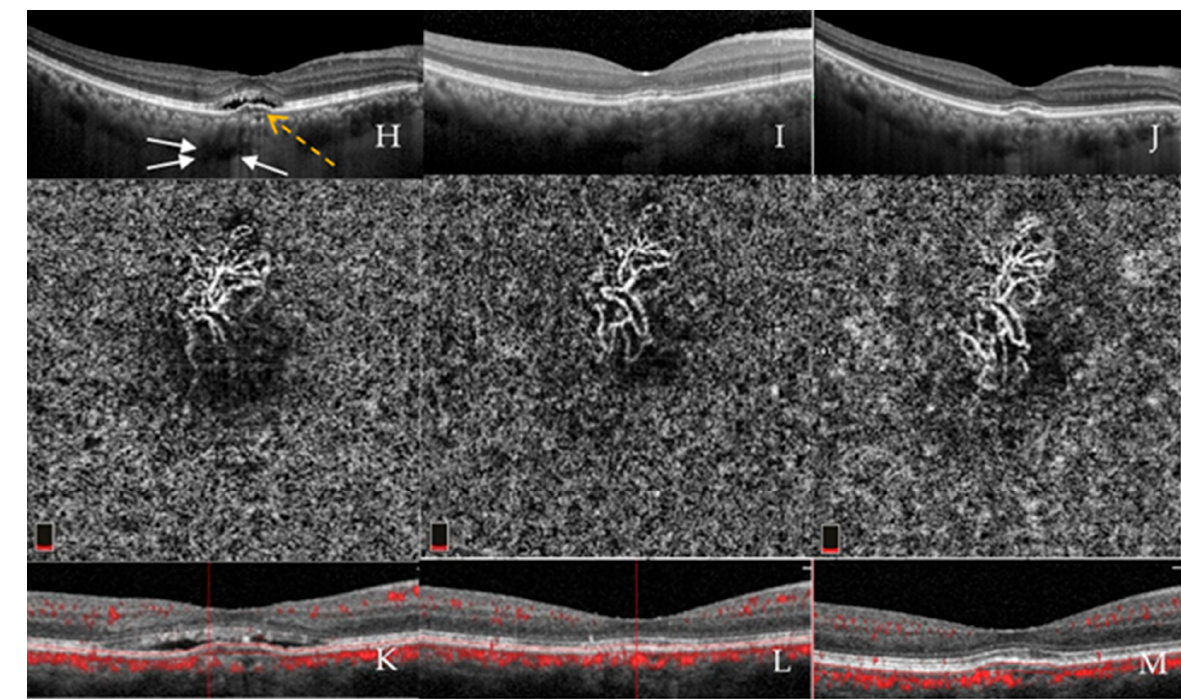
Figure 3. Multimodel imaging of 63-year-old PNV patient. Color fundus graph at baseline ( A ). Fluorescein angiography in the early phase showed a hyperfluorescent area corresponding to PNV ( B ). Fluorescein angiography in the late phase showed the same hyperfluorescent area as in B ( C ). Fundus autofluorescence showed a hypofluorescent lesion in the macula at baseline ( D ). Indocyanine green angiography in the early phase showed a hyperfluorescent area corresponding to PNV ( E ). Indocyanine green angiography in the late phase showed a hyperfluorescent area corresponding to PNV, and choroidal hyperpermeability was seen in the arcade; arrows ( F ). Fundus autofluorescence at 12 months after PDT ( G ). Optical coherence tomography (OCT) at baseline. Serous retinal detachment, irregular retinal pigment epithelium; dotted arrow and pachyvessels were seen; arrow ( H ). OCT one month after PDT. Dry macula ( I ). OCT 12 months after PDT. Dry macula with no additional injection ( J ). 3 mm × 3 mm OCT angiography (OCTA) with B-scan at baseline ( K ). OCTA 1 month after PDT ( L ). OCTA 12 months after PDT. Network vessel were getting large ( M